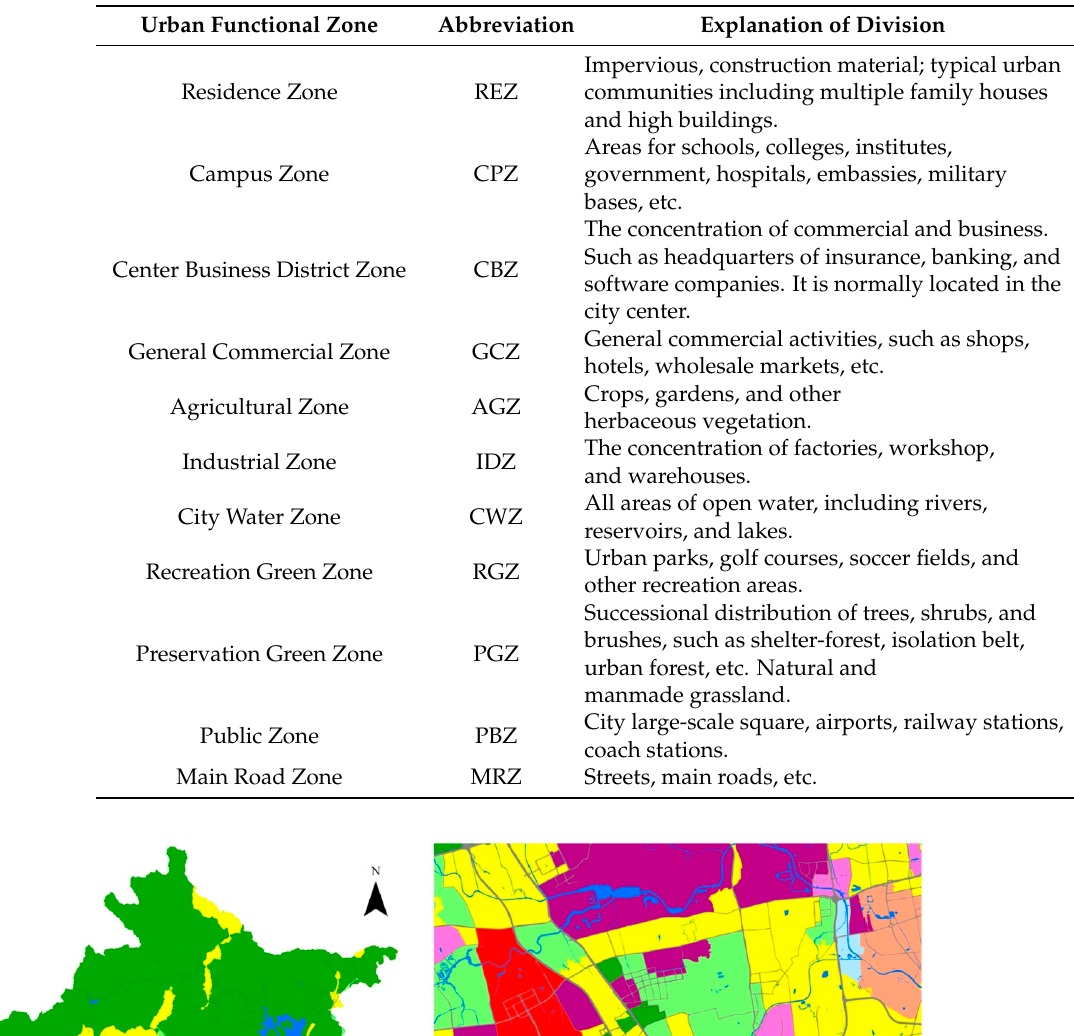
Table 2. Urban functional zone acquisition and interpretation.